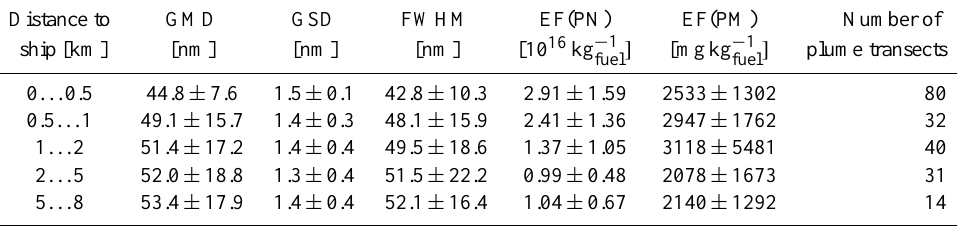
Table 4. The geometric mean diameter (GMD), geometric standard deviation (GSD) and full width at half maximum (FWHM) as well as the emission factors for particle number and mass are shown. GMD, GSD and FWHM are related to the number size distributions. The values were averaged for intervals of the distance to ship at the moment the plume was traversed. Distances were retrieved for 202 transects. Distance